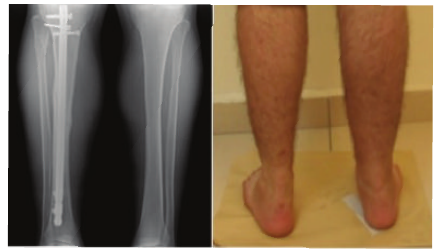
Figure 3: Clinical images showing the crus heel relationship.